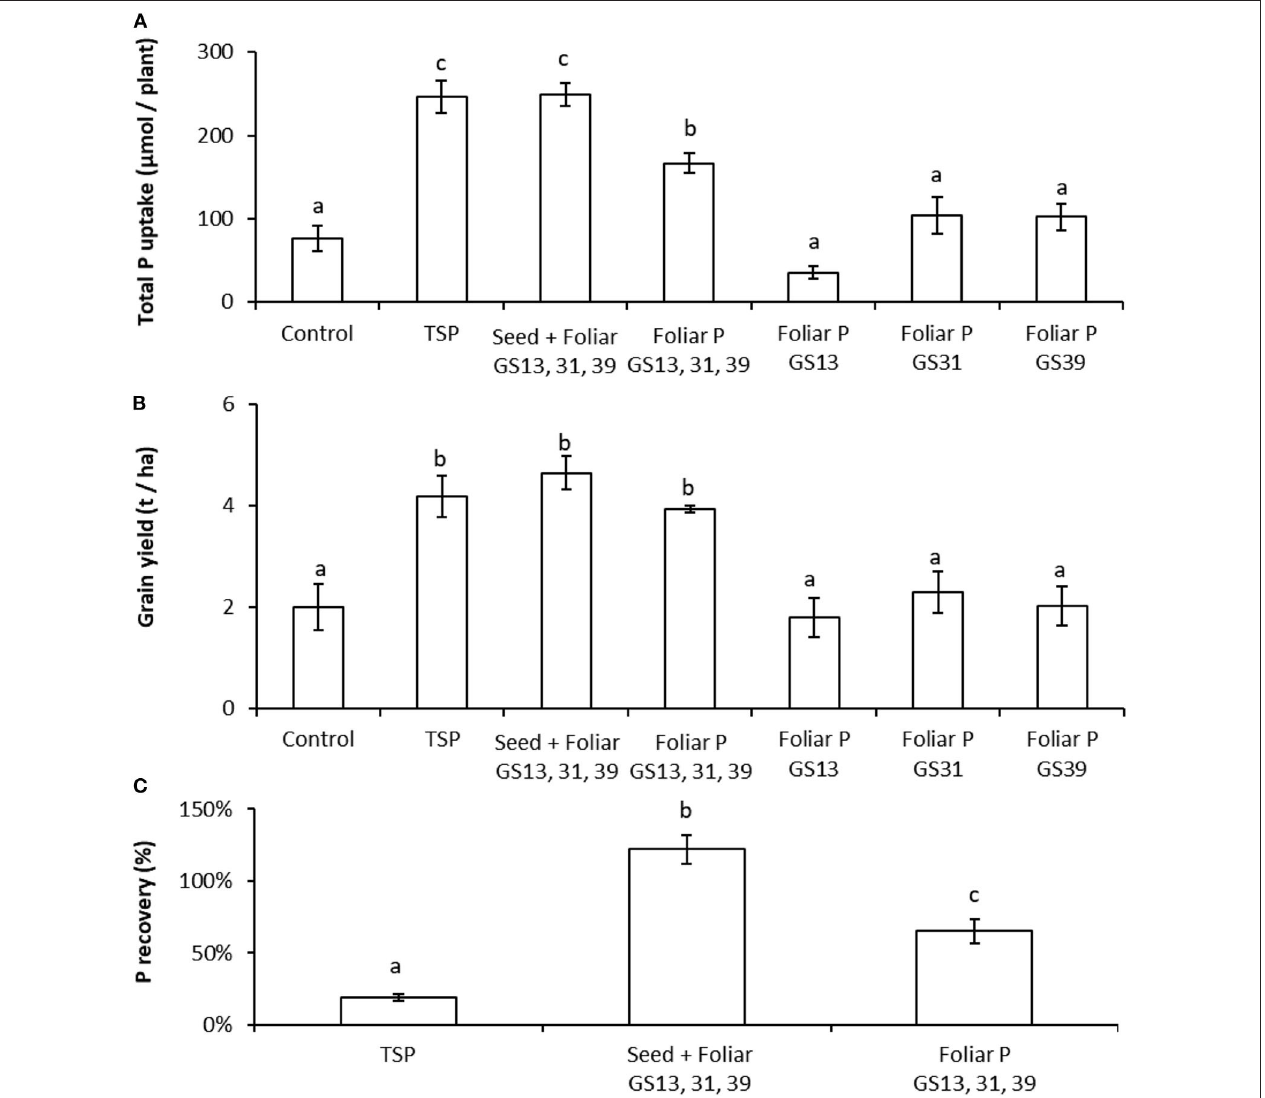
FIGURE 4 | Combining foliar P application with seed P dressing can produce comparable yields of Triticum aestivum to soil P fertilization with greater P recovery rates over the untreated control in P-limiting conditions. Panel (A) : Total P content of soil grown wheat plants grown to maturity with P-fertilization regimes of untreated control; triple super phosphate (TSP) granules placed in soil (885 µ mol P plant − 1 ); single or triple applications of foliar P (46.3 µ mol P plant − 1 application − 1 ); and seed dressing (3 µ mol P plant − 1 ) combined with three foliar applications (46.3 µ mol P plant − 1 application − 1 ). Panel (B) : Grain yields scaled to t ha − 1 for the